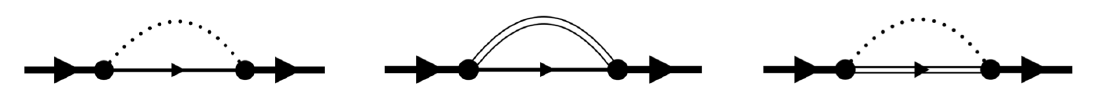
Figure 1 . Feynman diagrams contributing to the Roper resonance mass at one-loop order. The thick solid line with an arrow, the solid line with an arrow and the double solid line with an arrow refer to the Roper resonance, the nucleon, and the ∆ -dimer field, respectively. The dotted line represents pions and the double solid line the σ -dimer